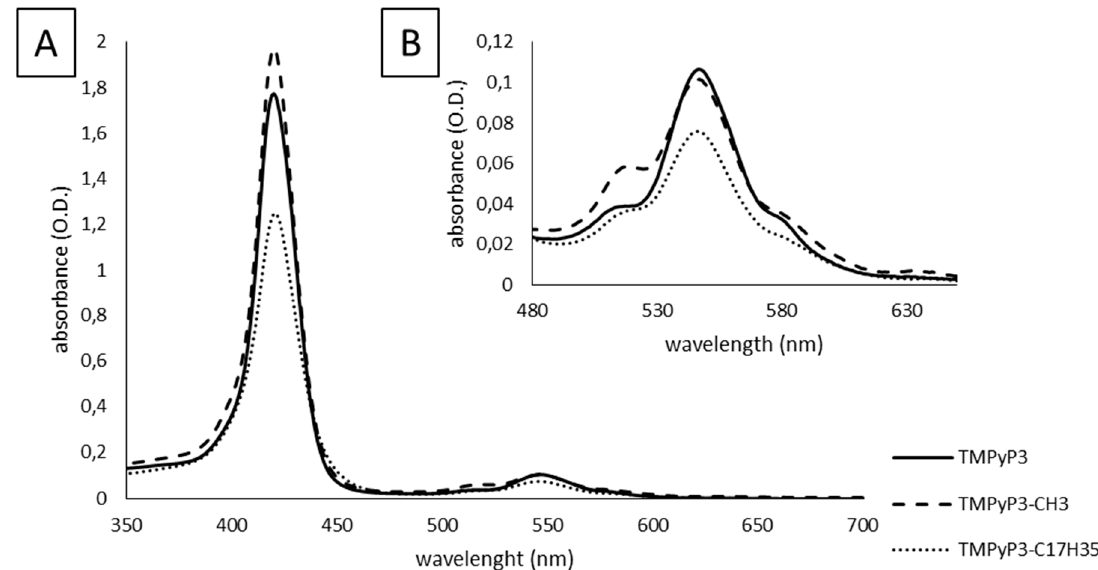
Figure 1. Comparison of ( A ) UV–Vis absorption spectra and ( B ) Q-bands of UV–Vis absorption spectra (enlarged), of porphyrins TMPyP3, TMPyP3-CH 3 and TMPyP3-C 17 H 35 (10 µM) in tap water.